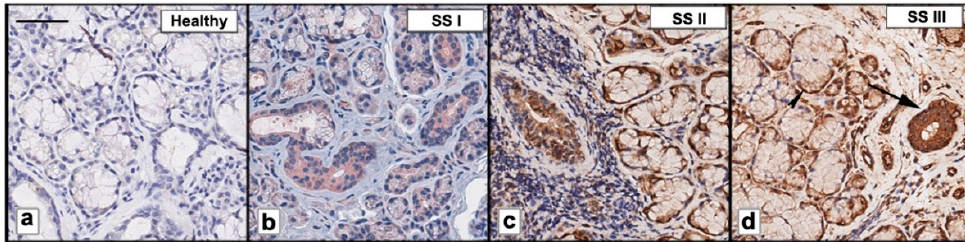
Figure 1. FSTL1 was immunohistochemically evaluated in pSS biopsy samples classified as I, low; II, intermediate; and III ( b – d ). Healthy SGs bioptic specimen was used as control ( a ). As observed, FSTL1 acinar cell expression was weak while FSTL1 staining was more pronounced in ductal epi- thelium ( b – d ); furthermore, a positive correlation was found between FSTL1 staining and inflam- matory degree ( b – d ). Brown staining shows positive immunoreaction; blue staining shows nuclei. Bar = 20 μ m. Arrows show FSTL1 distribution in ducts (large arrows) and acini (small arrows). Bar = 20 µ m. Arrows show FSTL1 distribution in ducts (large arrows) and acini (small